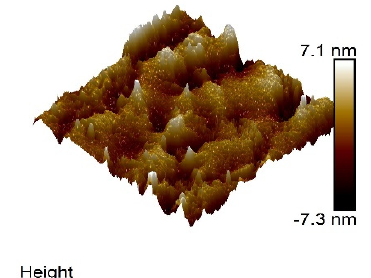
Fig .10. AFM image of nanocellulose